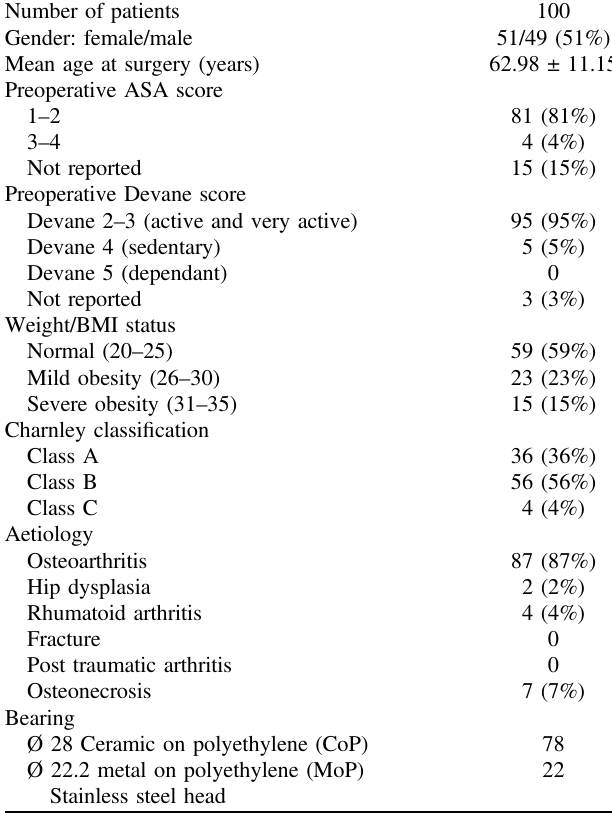
Table 1. Characteristics of the cohort.